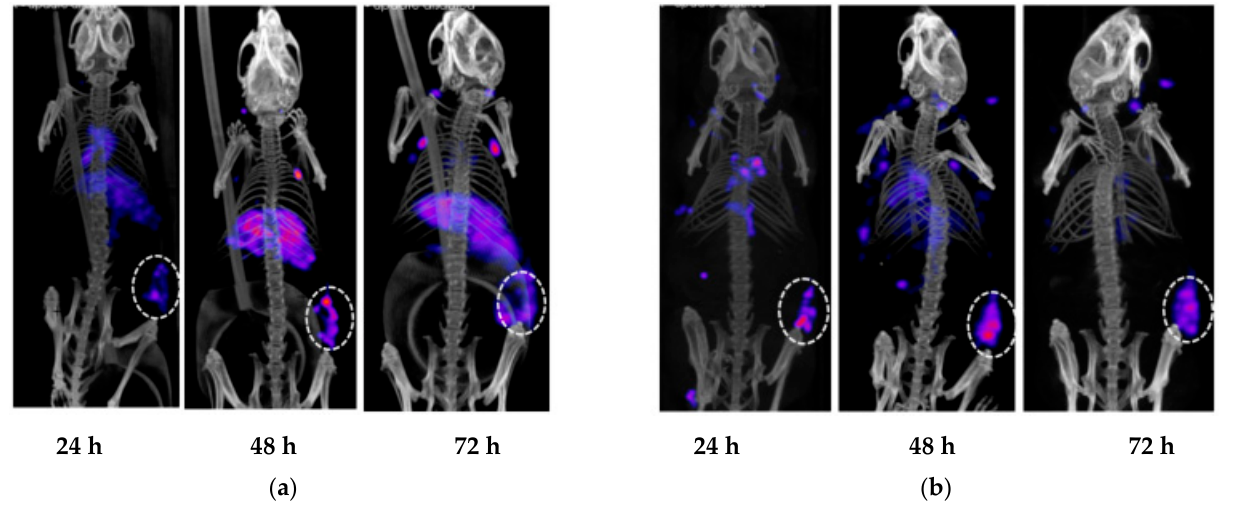
Figure 4. Small animal SPECT/CT imaging of LnCAP xenografts with ( a ) 111 In-DTPA-m5A10 and ( b ) 111 In-DTPA-h5A10. The in vivo targeting of 111 In-labeled m5A10-DTPA or h5A10-DTPA was verified in LnCAP-bearing xenografts. Tumors are well visualized on the right flank, as indicated in rings. The images are scalled to the same intensity. Higher radioactivity in the liver is observed for the murine compared to the humanized 5A10. Region-of-interest (ROI) analysis at the SPECT images at 24 h showed a liver accumulation of 7 % of injected activity for m5A10 as compared to 5 % for h5A10. These values are within the uncertainty limits.